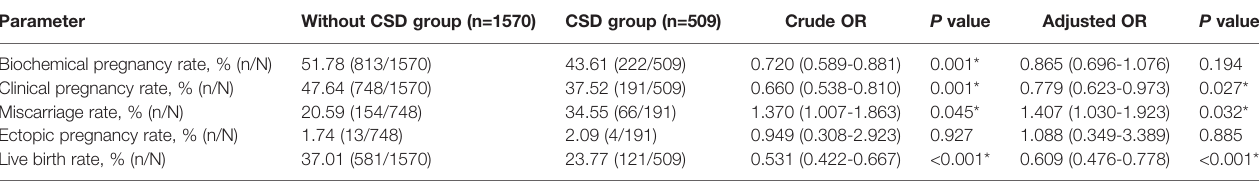
TABLE 5 | Logistic regression analysis of reproductive outcomes of patients with and without CSD. Parameter Biochemical pregnancy rate, %